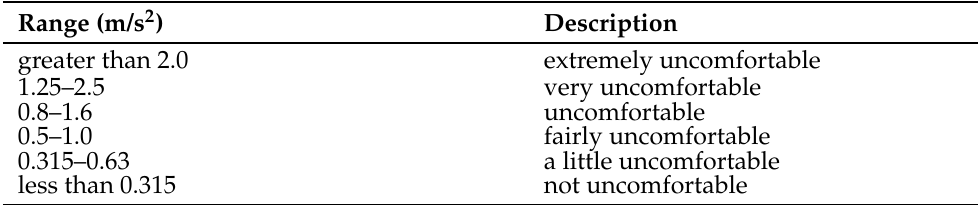
Table 1. Comfort index ( A v ) and its relation with general discomfort